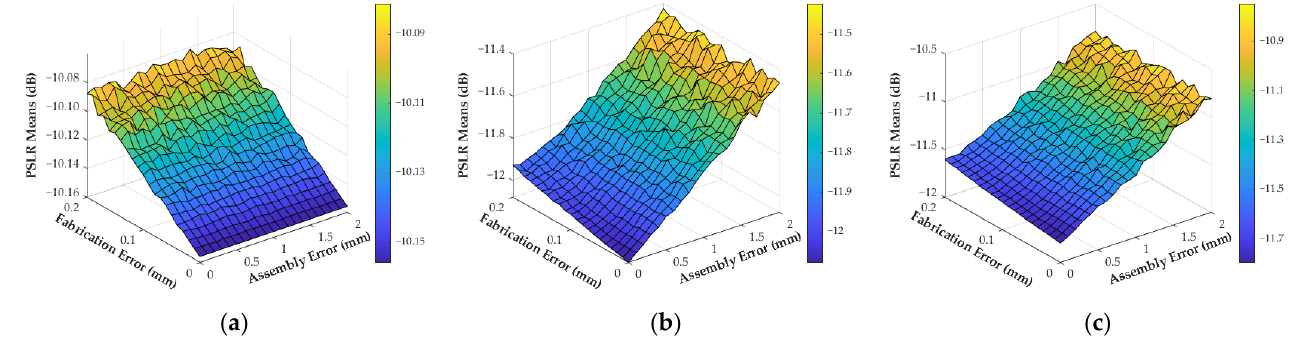
Figure 9. The sidelobe suppression performance with manufacturing errors: ( a ) SRS detection type; ( b ) MRS detection type; ( c ) LRS detection type. The sidelobe suppression performance also decreases with the manufacturing errors.